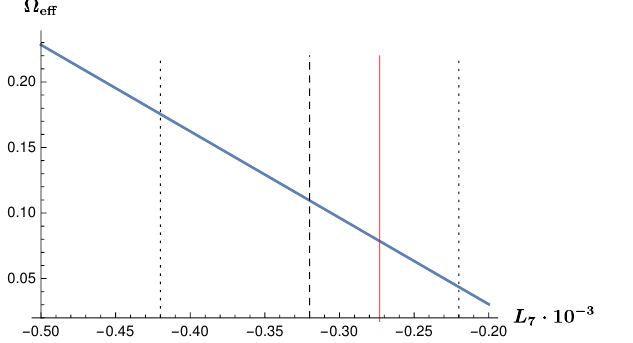
Figure 2 . Central value of (cid:10) e(cid:11) as a function of L 7 . The dotted vertical lines indicate the range of L 7 in eq. (4.13), while the red line is the large- N C value from eq.